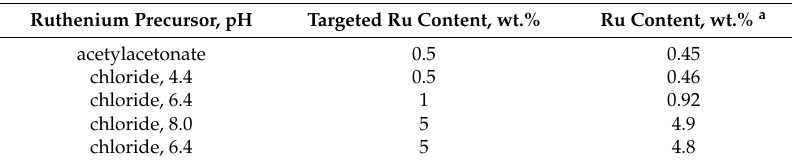
Figure 1. Disappearance of the Ru precursor in the presence of TiO 2 -P25 as a function of the illumination time for ( A ) Ru(acac) 3 and ( B ) RuCl 3 precursors, with a Ru concentration ranging from 0.5 to 5 wt.%. Inset: UV-vis absorbance spectra evolution as a function of time during the photon-assisted synthesis for 0.5 wt.% of Ru. Table 1. Ru content in Ru/TiO 2 materials determined by inductively coupled plasma optical emission spectroscopy